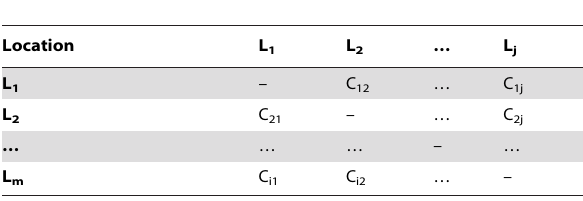
Location Archetype Keyword